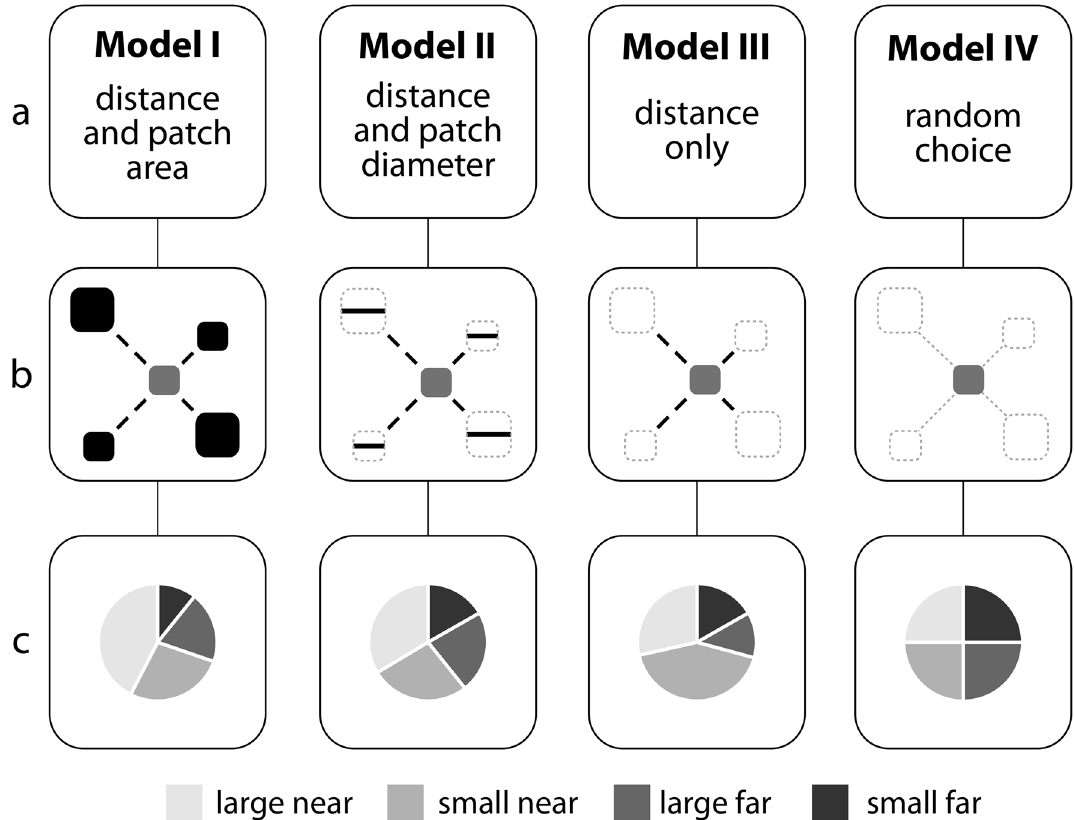
Figure 1. Models of patch attractiveness and derived predictions. ( a ) The parameters of the four models of patch attractiveness. ( b ) Parameters of the four models of patch attractiveness illustrated within the experimental design. ( c ) Predicted probabilities of transitions from the center patch to each of the four peripheral patches derived for each of the four